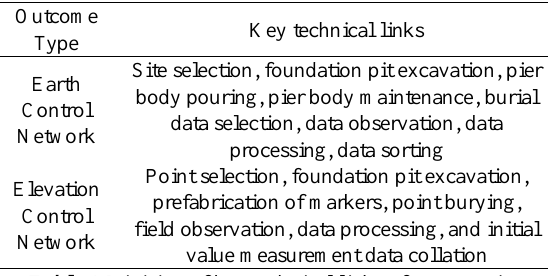
Table 1 .Division of key technical links of construction